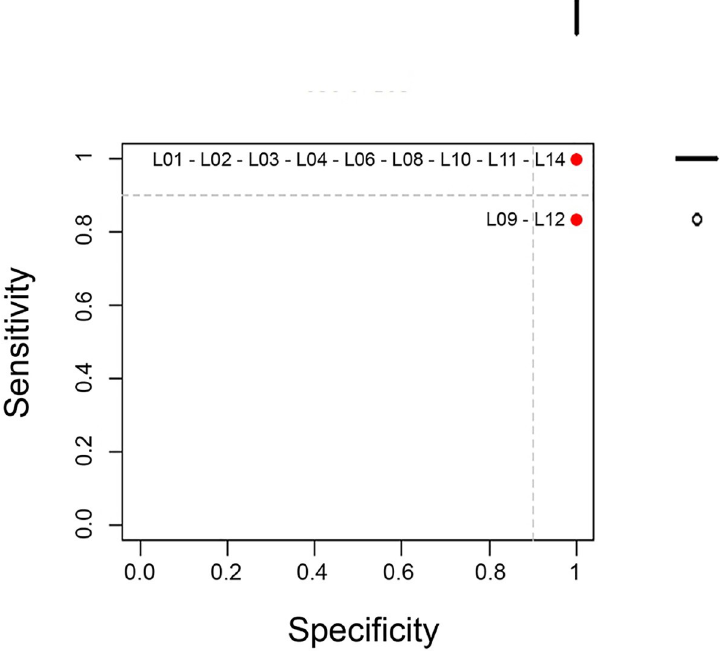
Fig 2. Scatter plot of sensitivity by specificity of RT-PCR submitted results. The sensitivity (y-axis) and the specificity (x-axis) are shown for each laboratory (red dots and laboratory ID). Nine laboratories out of eleven submitting results by RT-PCR correctly identified all samples. Those laboratories are found in the top right